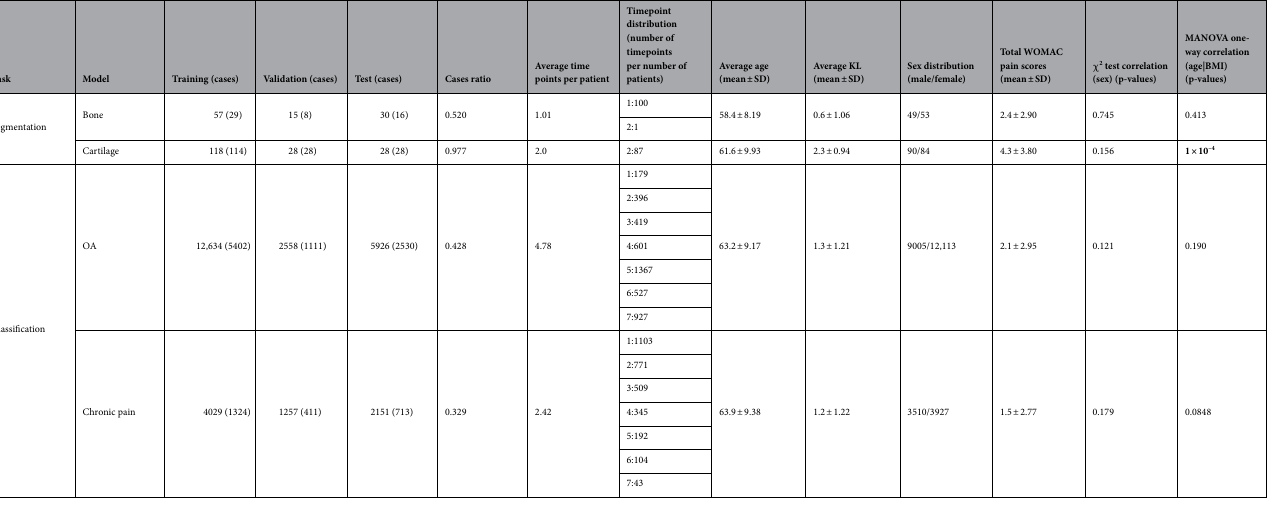
Table 4. Training, validation, and test splits information for the segmentation and classification models. Demographic factors were controlled by testing for statistical independence across the splits using a Pearson’s chi-squared test ( χ 2 ) for the categorical sex variable and a one-way Multivariate Analysis of Variance (MANOVA) for the joint effect of age and BMI. Bold p-values are significant (p-value <